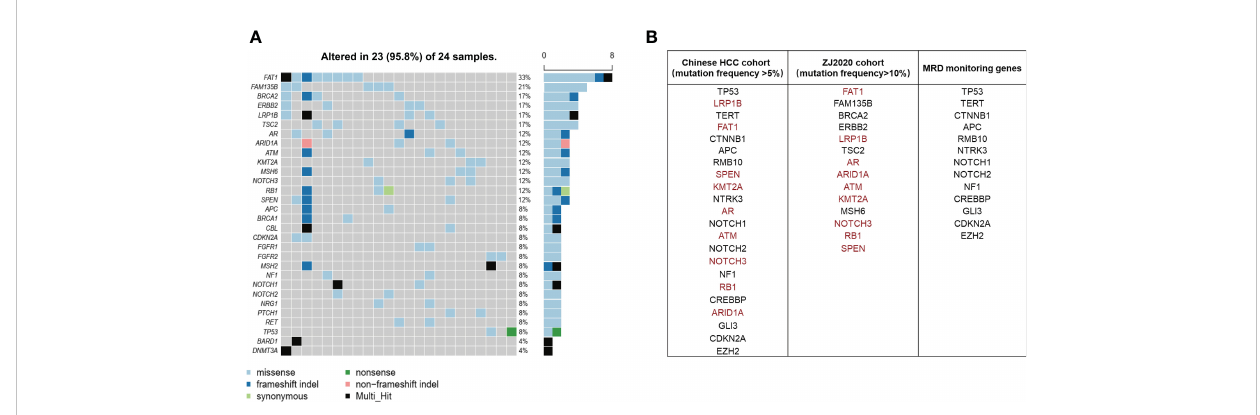
FIGURE 3 Screening of MRD monitoring genes. (A) The top 30 frequently mutated genes in the ZJ2020 cohort with HCC patients having RFS more than 2 years after radical resection. (B) The 14 genes with a mutation frequency of >10% in the ZJ2020 cohort are fi ltered out from the 27 genes with a mutation frequency of >5% in the Chinese HCC cohort, and the remaining 13 genes are used as MRD monitoring genes. HCC, hepatocellular carcinoma; MRD, minimal residual disease; RFS, relapse-free survival.